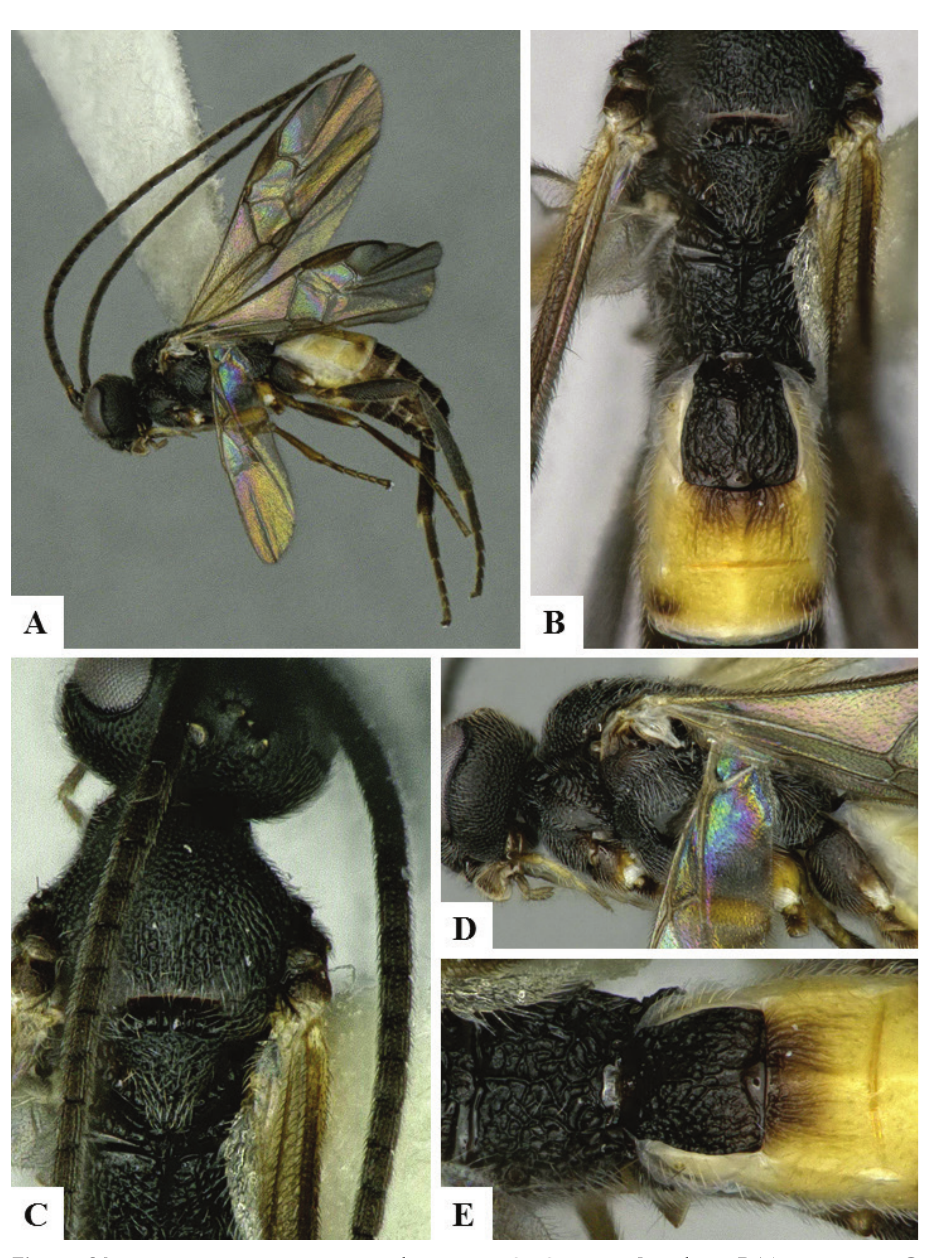
Figure 21. Jenopappius magyarmuzeum male paratype CNCH2789. A Habitus B Tergites 1 to 3 C Mesosoma dorsal D Mesosoma lateral E Propodeum and tergites 1 to 2. Male. As female. Biology. Host unknown. Distribution. Democratic Republic of the